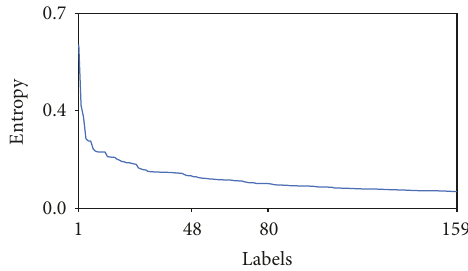
Figure 3: Entropy of each label in BibTeX